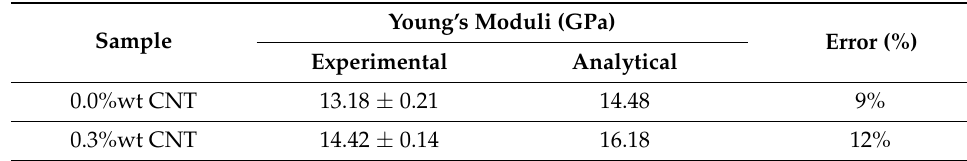
Table 4. Results of the Young’s modulus model.